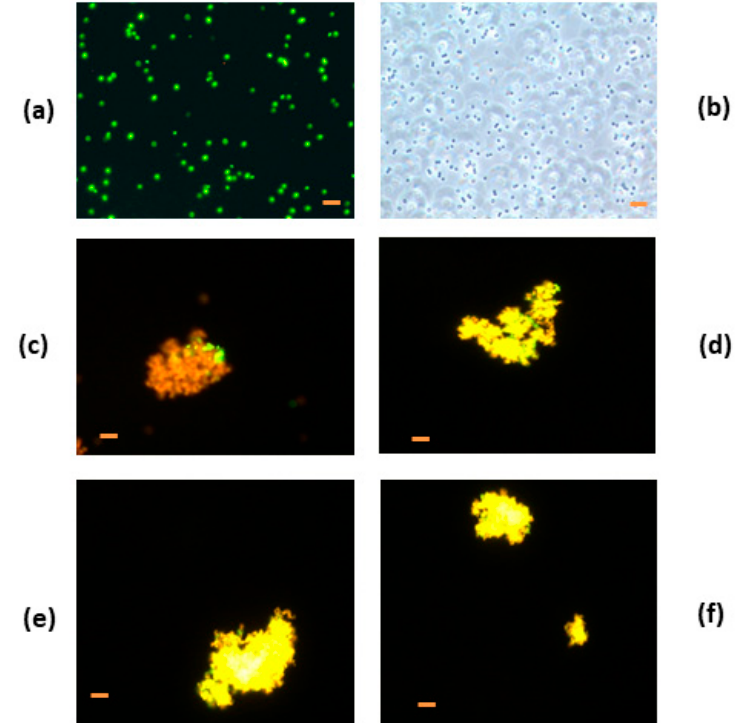
Figure 5. Fluorescence micrographs of Staphylococcus carnosus incubated with heat-treated hen egg white lysozyme (HEWL) at pH 6.0. ( a ) S. carnosus control without HEWL, ( b ) S. carnosus control without HEWL without fluorescence, ( c ) S. carnosus incubated with HEWL/80 °C, ( d ) S. carnosus incubated with HEWL/90 °C, ( e ) S. carnosus incubated with HEWL/95 °C, and ( f ) S. carnosus incubated with heat-treated HEWL/120 °C. Bacteria control and bacteria with sample were incubated for 15 h at a concentration of 0.5 mg/mL. Bar = 2 μ m.